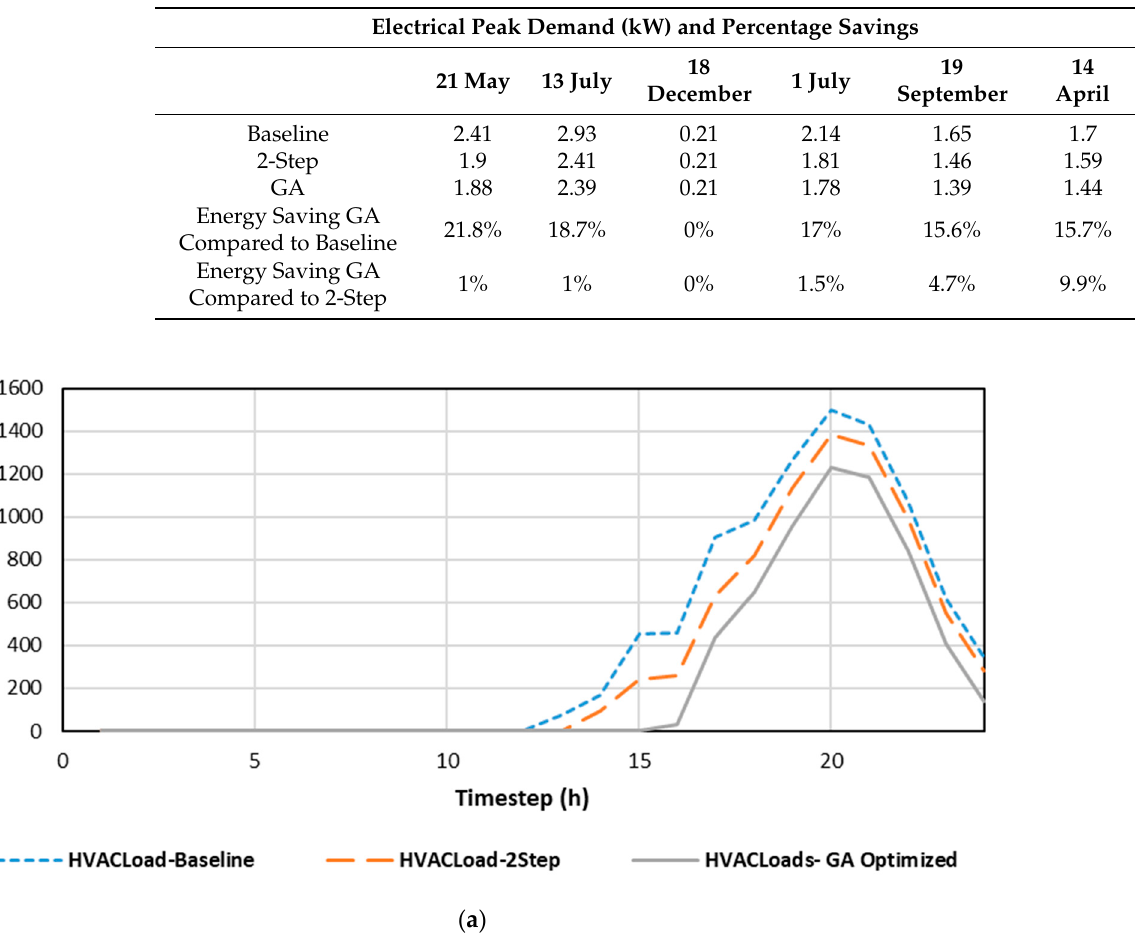
Table 11. Electrical peak demand for baseline windows and optimized STIS–smart windows applied to a house in Chicago, IL, USA for six representative days using two control strategies.